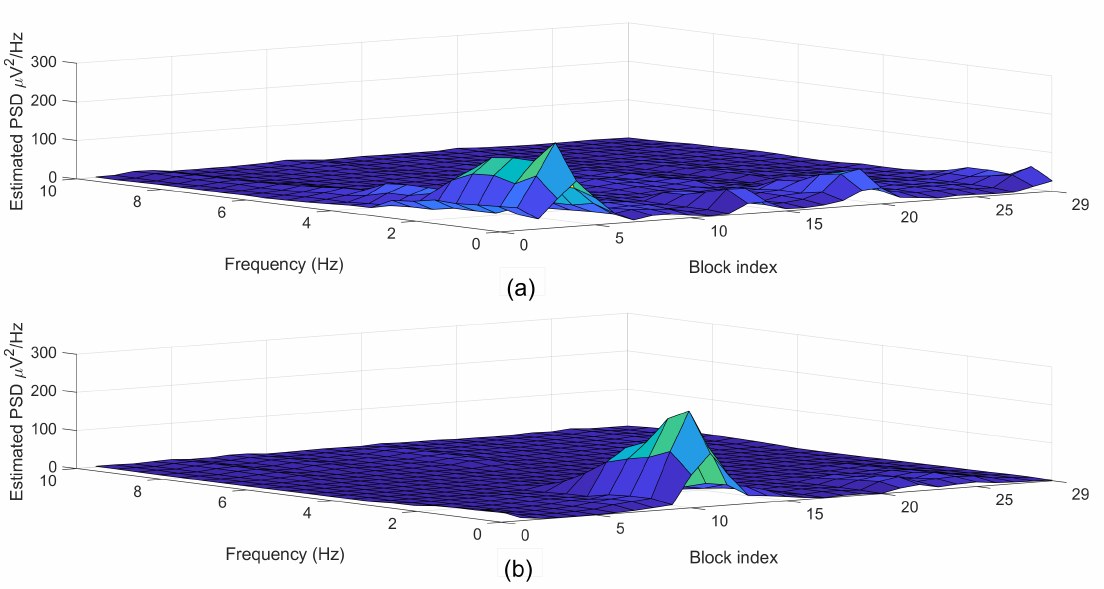
Figure 6. Examples of ( a ) normal (label = 0) and ( b ) arousal (label = 1) segments each with a 30-s length.